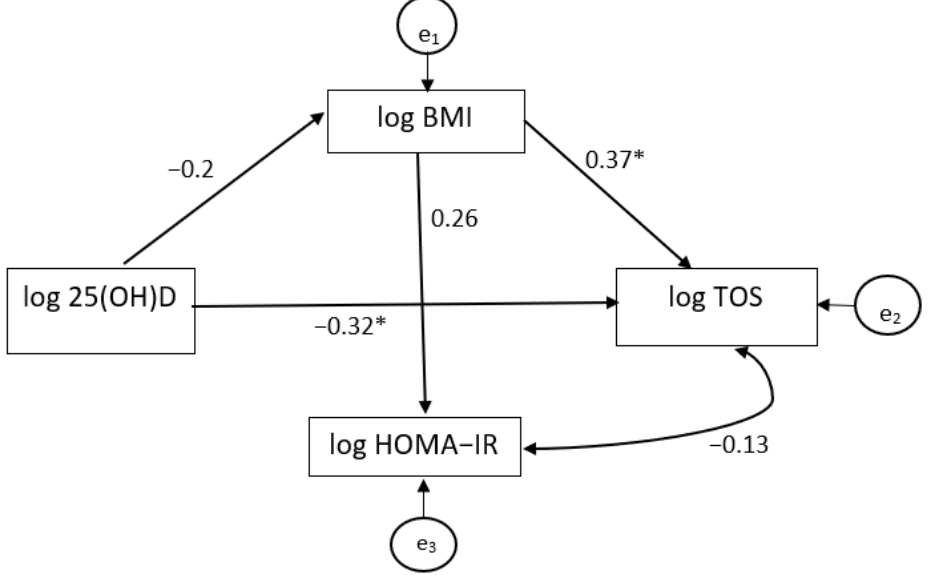
Figure 1. Path model for the effect of serum 25(OH)D concentrations on BMI and TOS (log-transformed variables) in overweight/obese patients with T2DM. Single-headed arrows indicate direct effect/relationships (effect size being represented by standardized path coefficients) while double-headed arrows indicate linear correlations; * p < 0.05: significant standardized path.